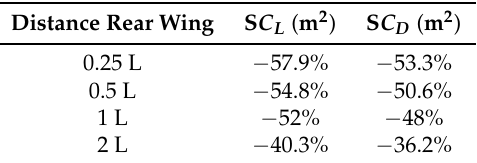
Table 8. Percentage of change of the aerodynamic coefficients in the rear wing of the second car as regards the first